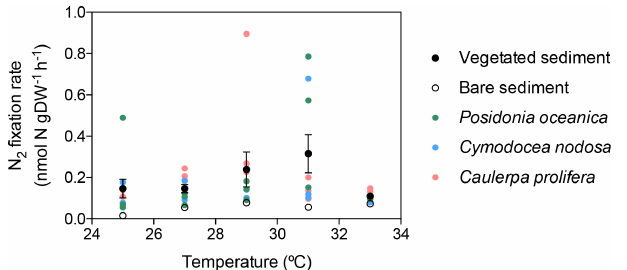
Figure 2. Relationship of experimental incubation temperature and mean sediment N 2 fixation rates (expressed by sediment dry weight) in vegetated (black dots) and bare sediments (open dots). Black and open dots indicate mean values, and errors bars indi- cate standard error of the mean. Individual replicate measurements of N 2 fixation rates for each macrophyte species are also shown in colored-coded dots; green dots represent measurements on P. oceanica sediments, blue dots represent measurements on C. no- dosa sediments, and pink dots represent measurements on C. prolif- era sediments.